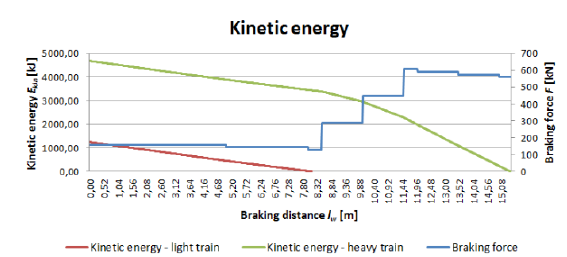
Figure 5. Kinetic energy and braking force along the braking distance (Example 2).